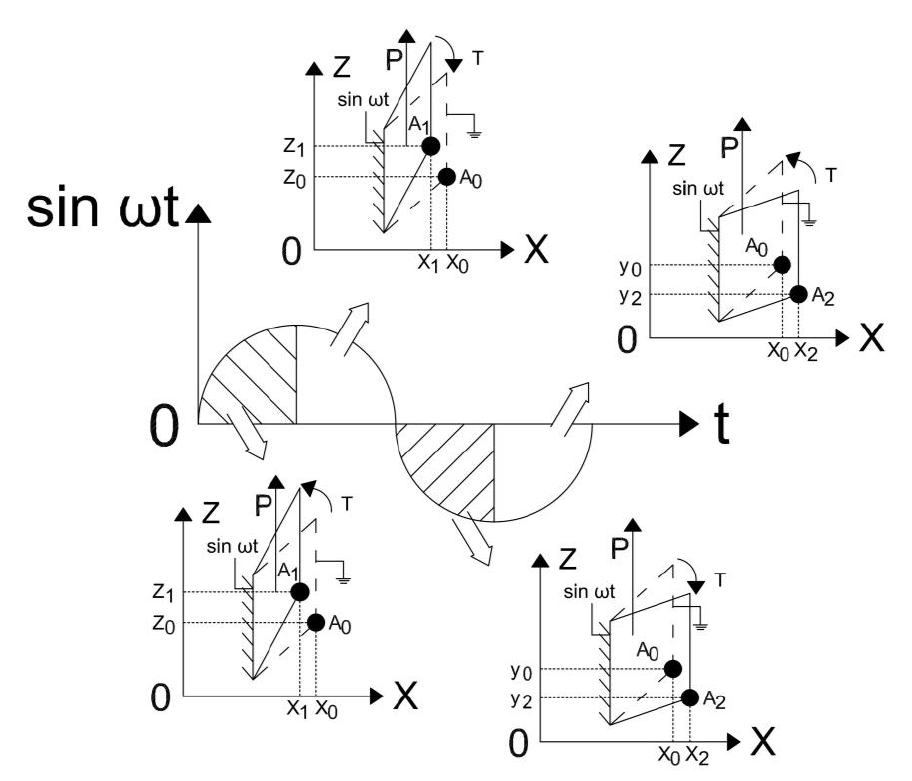
Figure 2. Vibration principle of the PZT ceramic. (P and the arrow next to it mean the direction of polarization of the ceramic. T and the arrow next to it mean the direction of motion of the ce- ramic).